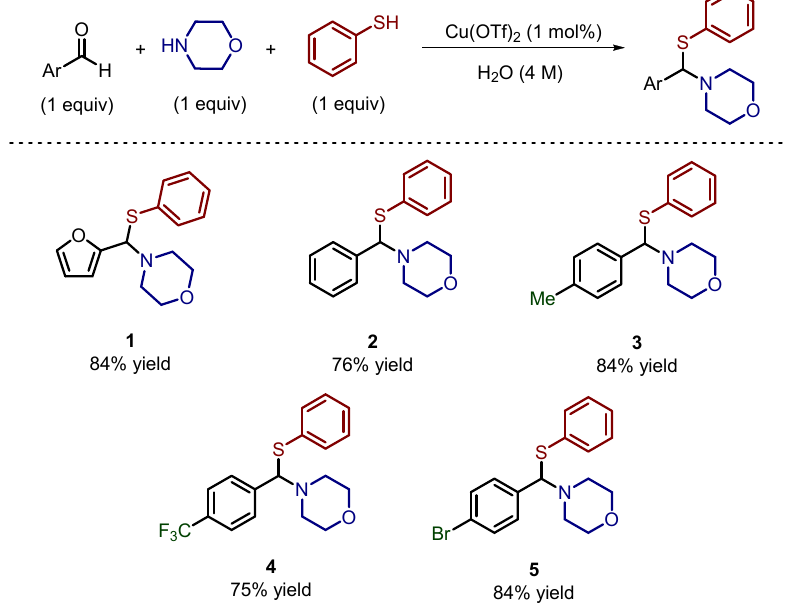
Scheme 1. Scope of aryl aldehydes for the formation of